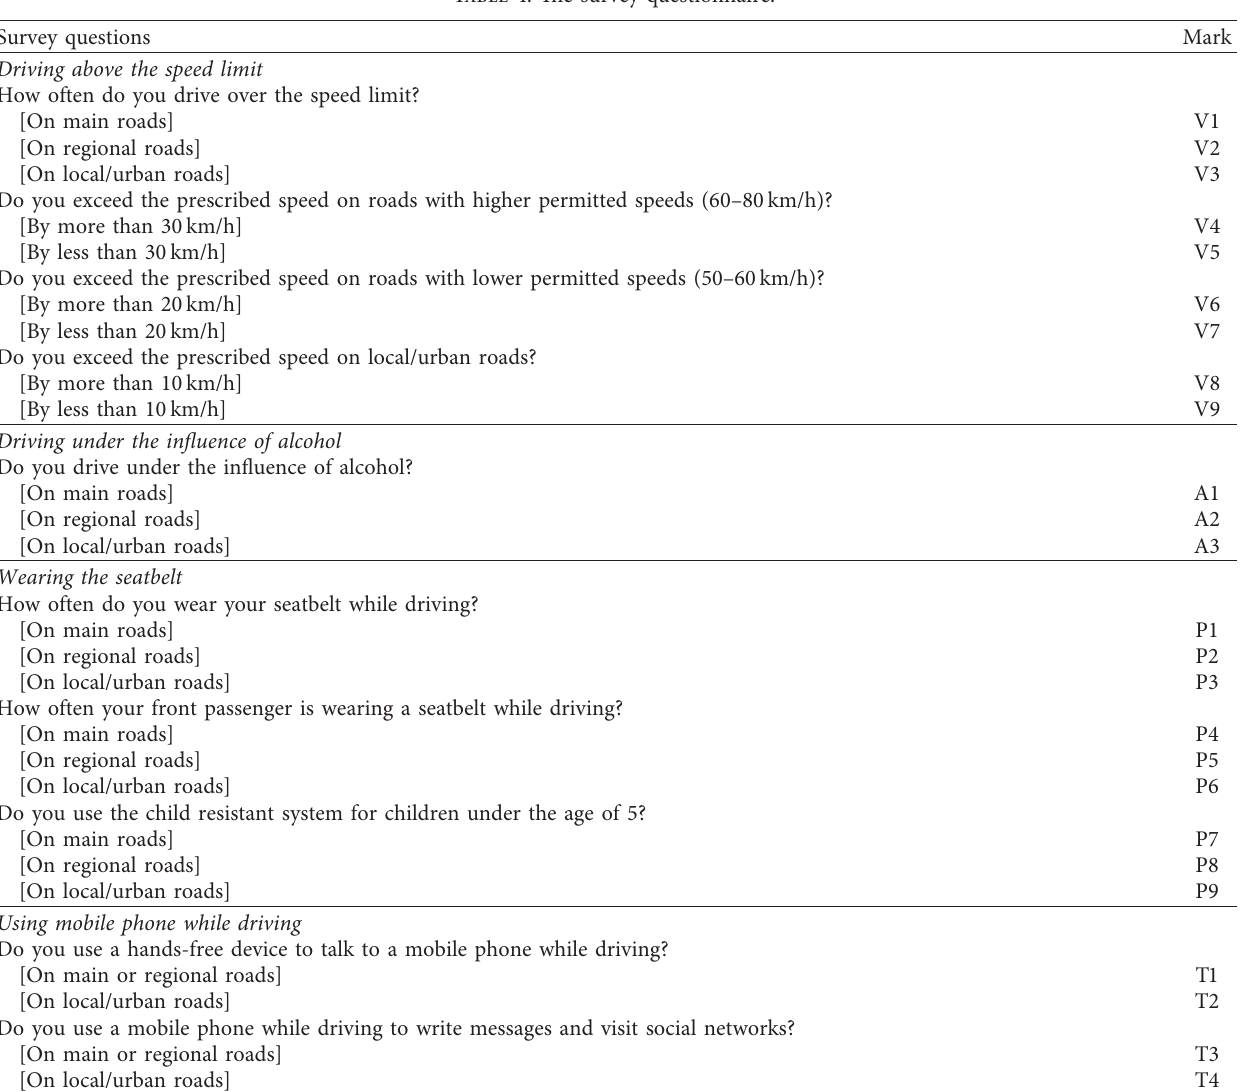
Table 4: The survey